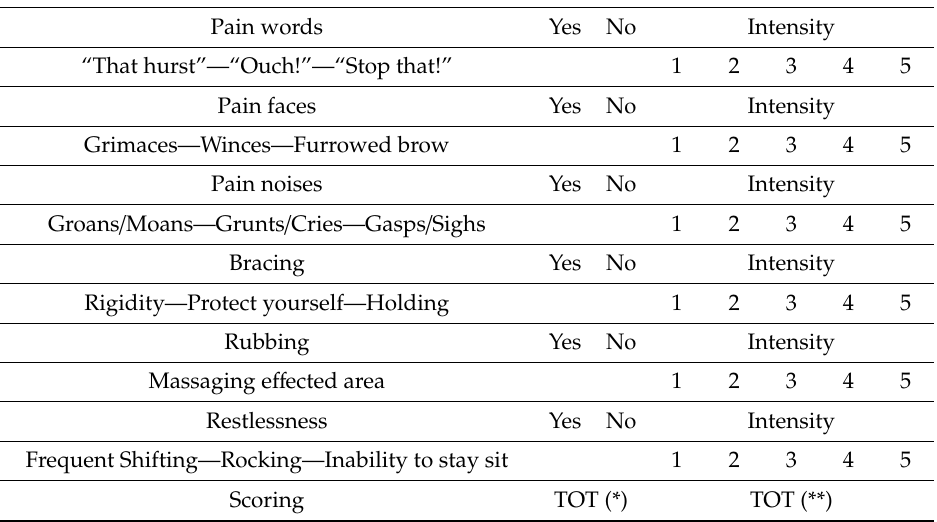
Table 2. Noppain scale